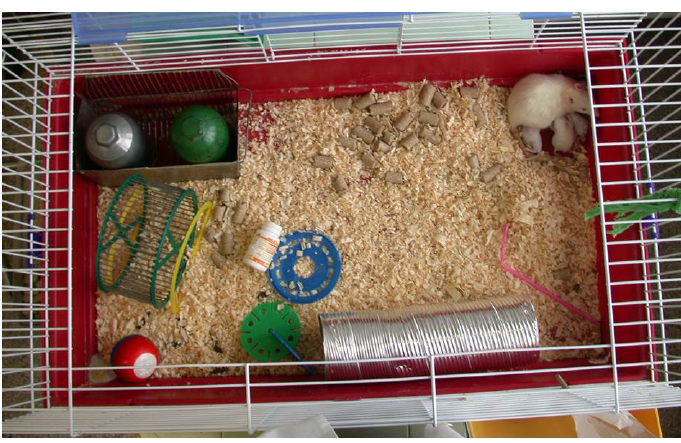
Figure 5. Enriched